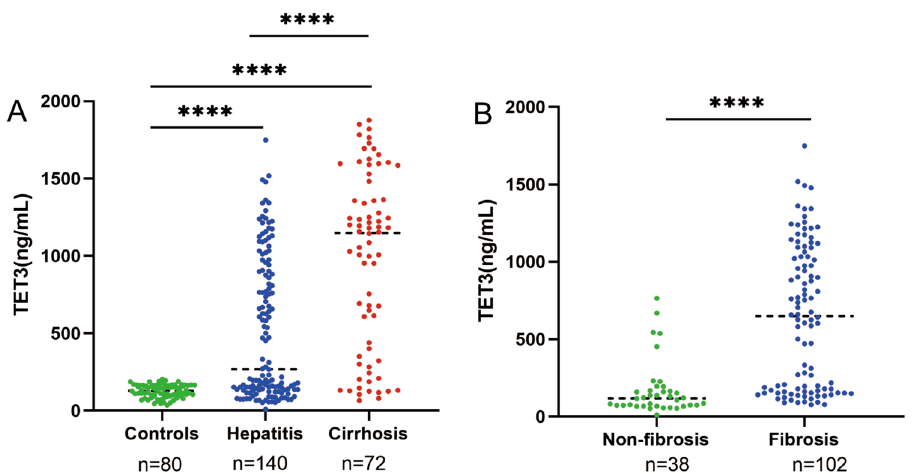
Figure 1. Serum TET3 level in chronic liver disease. ( A ) Comparison of serum TET3 levels in hepatitis, liver cirrhosis and controls; ( B ) Comparison of serum TET3 levels between the patients of fibrosis and non-fibrosis with